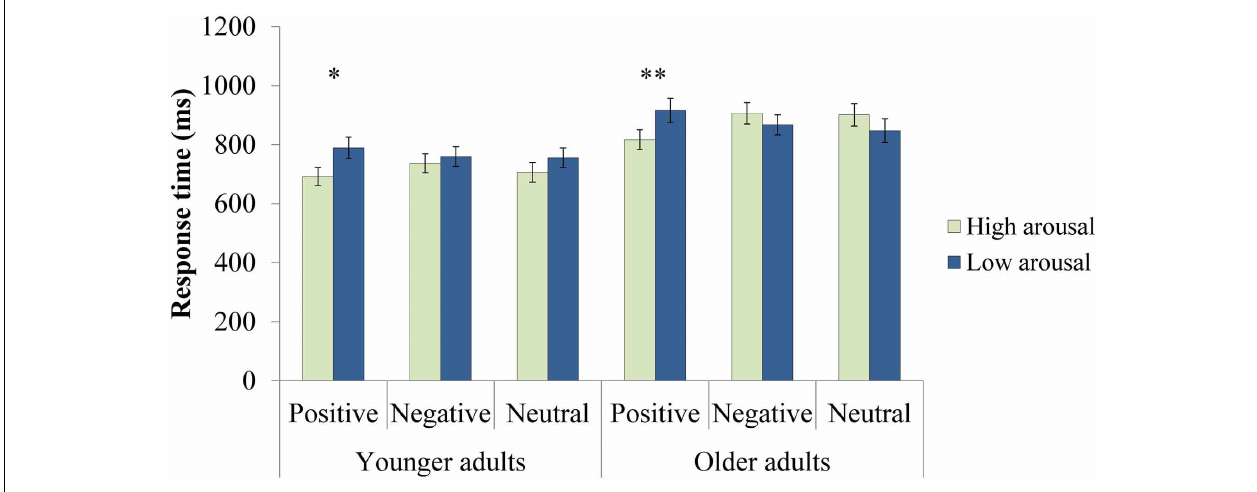
FIGURE 2 | Response times for correct target identification responses. Error bars represent standard errors. ∗ p < 0 . 05; ∗∗ p < 0 . 01.